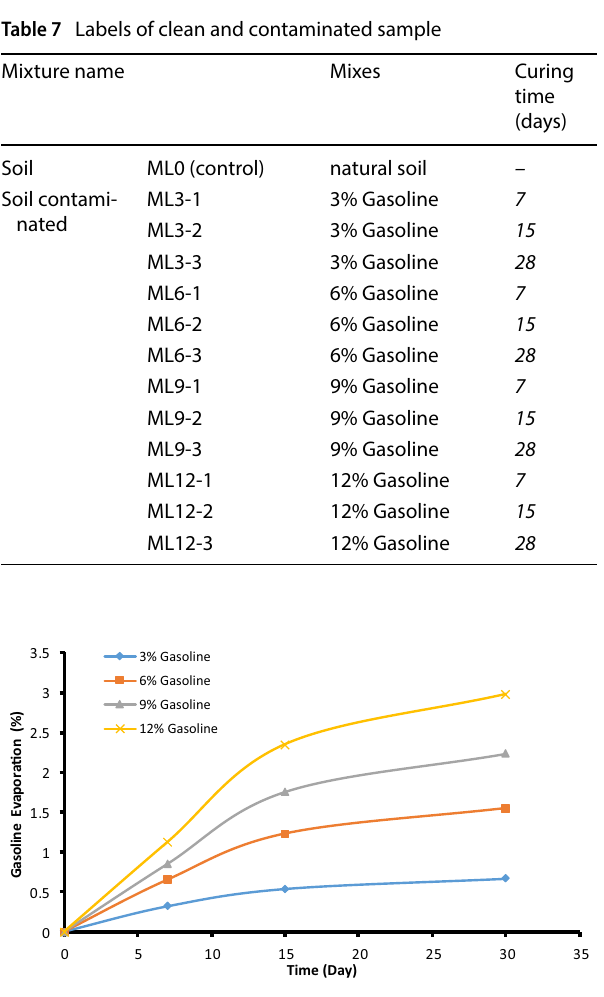
Fig. 5 Gasoline evaporation percentage and rate of samples in the laboratory